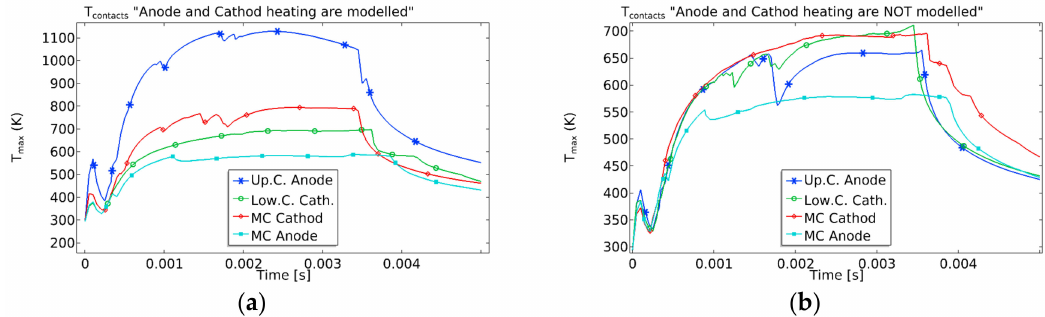
Figure 11. T max of contacts ( a ) with thermionic emission modeling, ( b ) Without thermionic emission modeling in 200 A peak